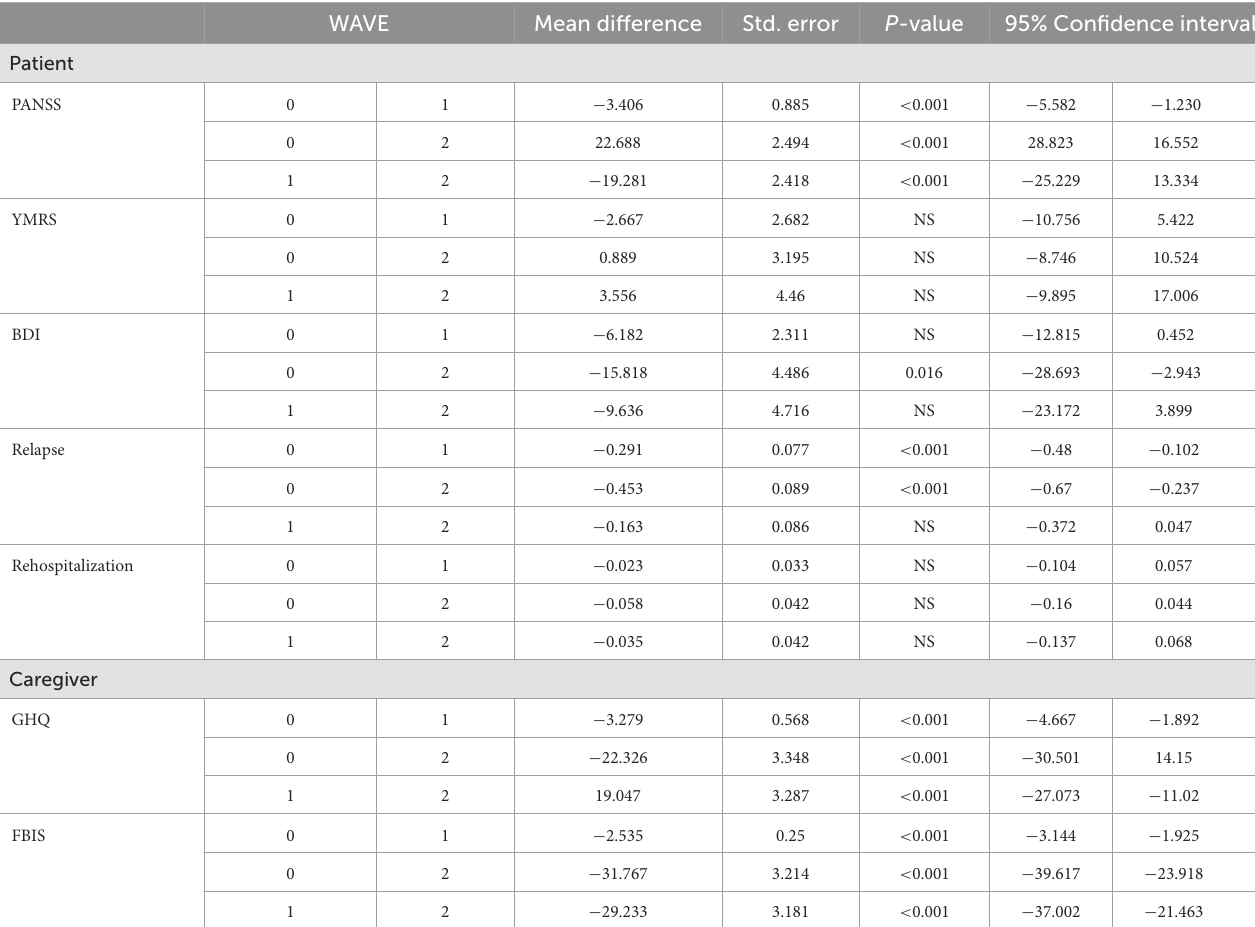
TABLE 3 Effect of time passing on